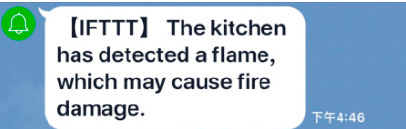
Figure 11. Notification messages on Line.